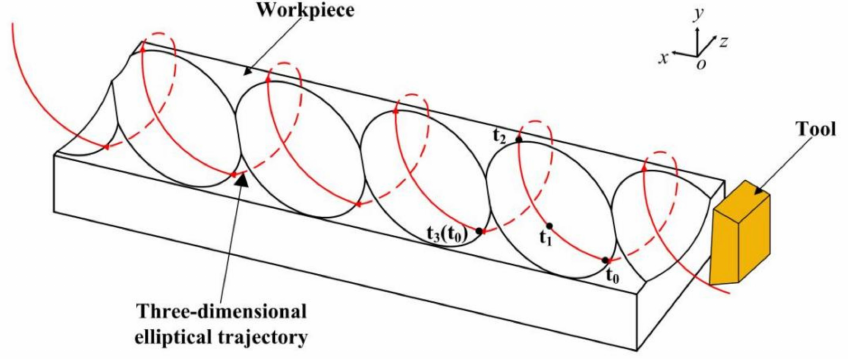
Figure 1. Principle of 3D-EVC.